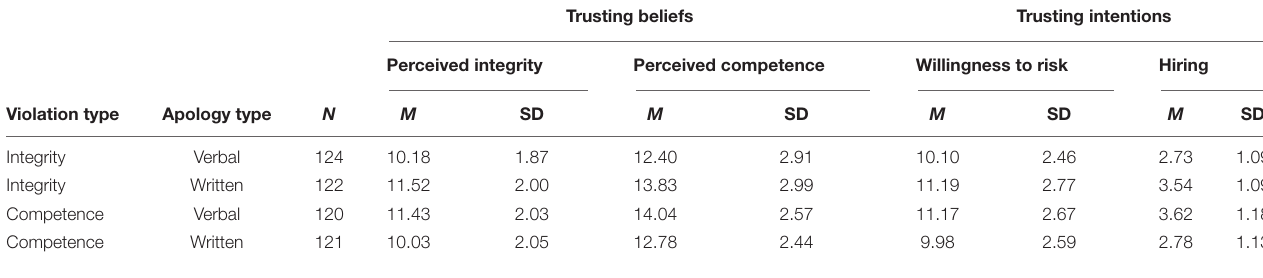
TABLE 2 | Study 1 means, standard deviations of verbal apology and written